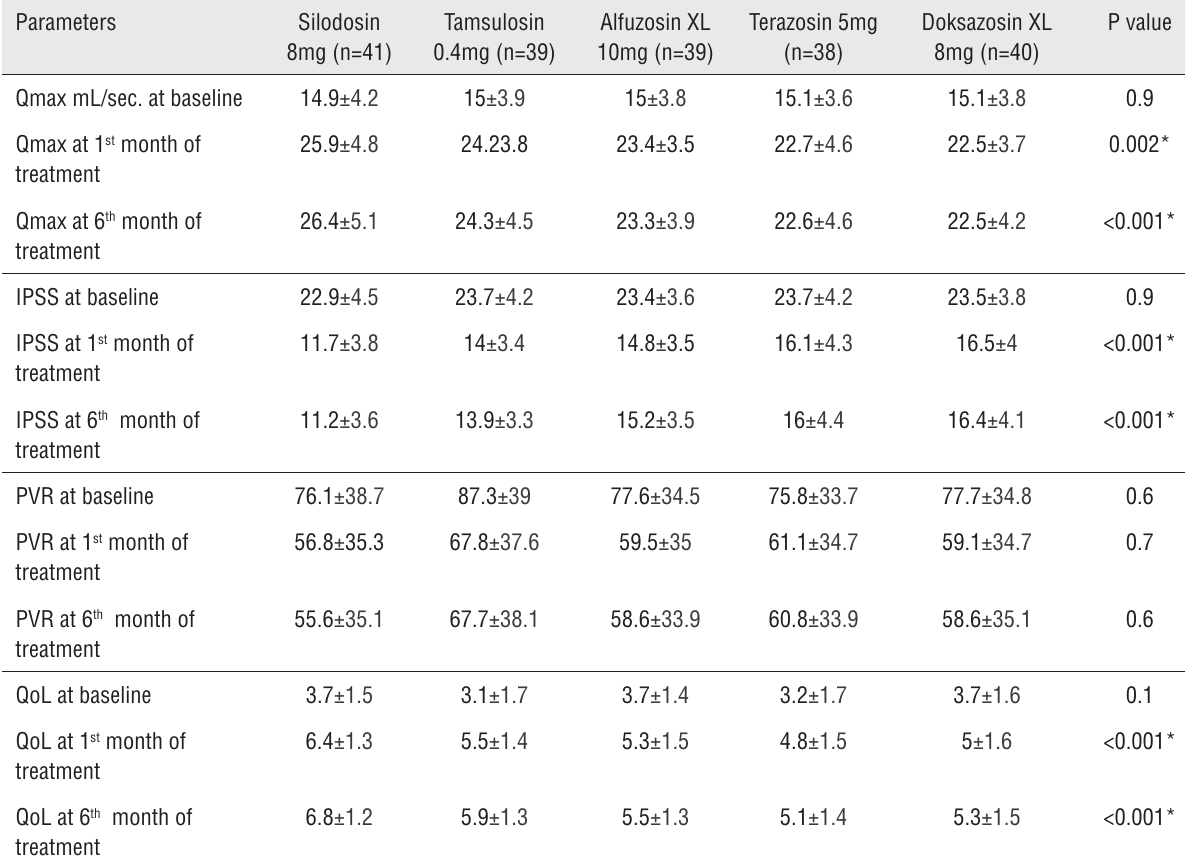
Table 5 - Comparison of response to treatment according to used